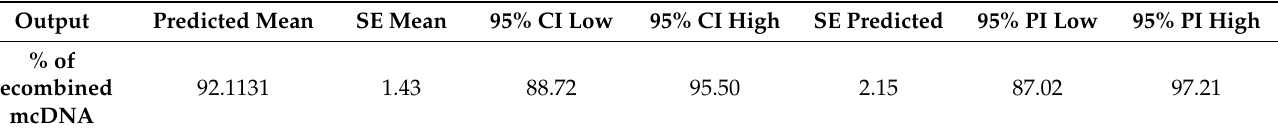
Table 4. Predicted outputs for optimal point. CI–Confidence